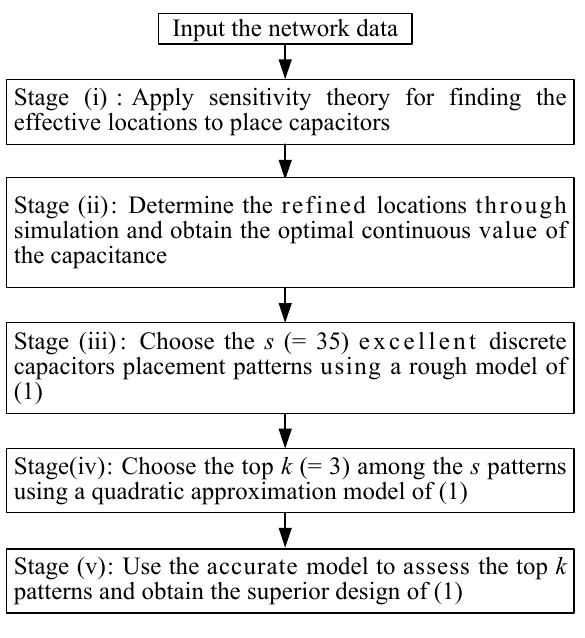
Figure 2. Flow diagram of the ordinal search algorithm.